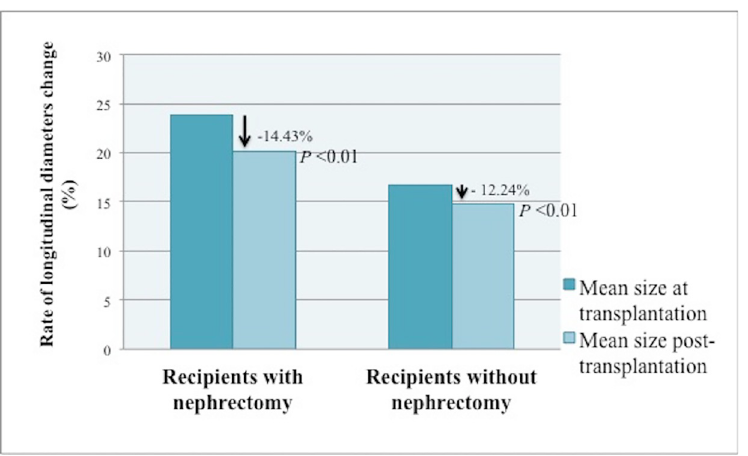
Fig 3. Rate of change in native kidney longitudinal diameters after transplantation. Patients with simultaneous nephrectomy and kidney transplantation were compared with patients who underwent a kidney transplant alone. Patients in both groups exhibited a statistically significant reduction of native polycystic kidney longitudinal diameters after transplantation, more pronounced in patients who underwent a simultaneous